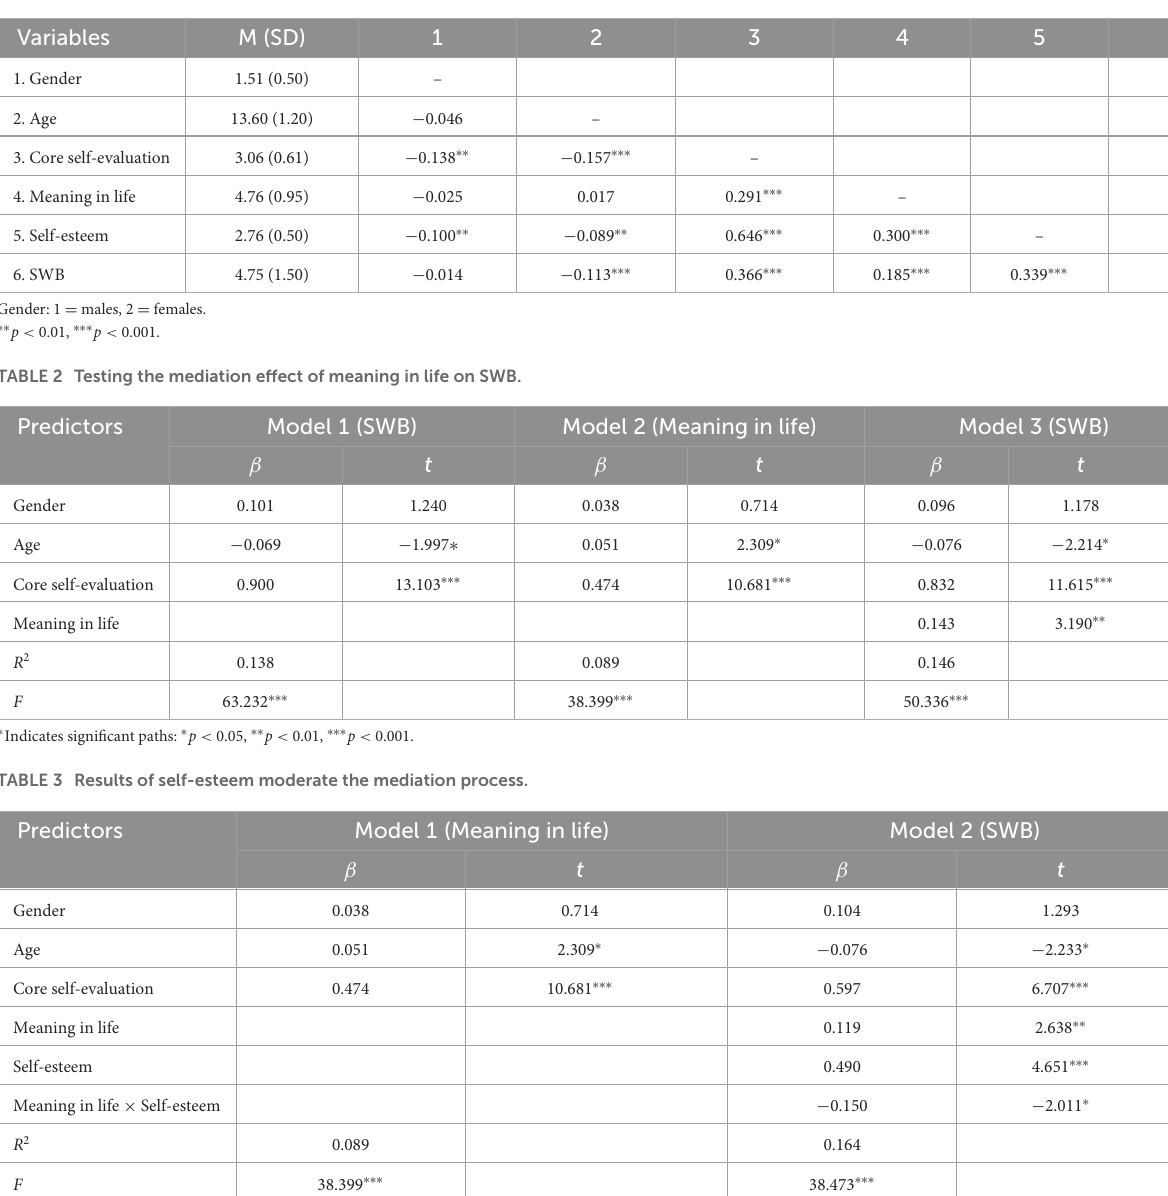
TABLE 1 Descriptive statistics and correlation analysis ( N = 1,185).